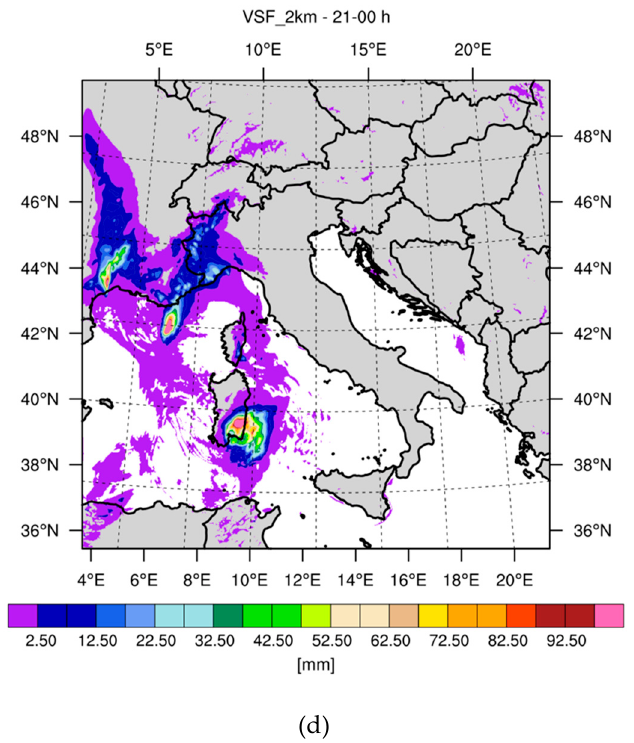
Figure 9. Accumulated precipitation between 21 UTC on 10 October 2018 and 00 UTC on 11 October 2018 for ( a ) CTRL; ( b ) VSF_3h; ( c ) VSF_1h; ( d ) VSF_2km. For VSF_1h and VSF_2km the precipitation is given by the sum of the three very short term forecast of 1 h between 21 and 00 UTC.